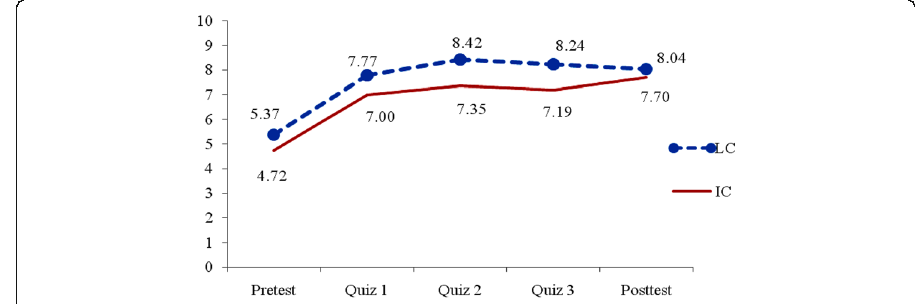
Fig. 2 EFL learners ’ ICC. This figure belongs to the finding of this